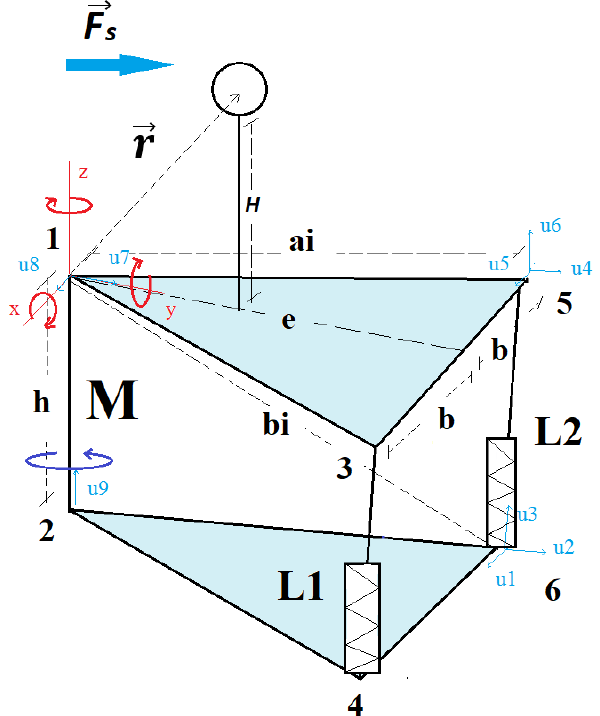
Figure 2. Simplified diagram of the parallel mechanism, where the plane triangles are isosceles and the line of length ‘e’ is the median of the triangle. The sphere is also represented, and within it is the → IMU. 𝐹 𝑠 ⃗⃗⃗ is the force resulting from the fluid dynamic forces, and 𝑟 is the vector of the center of the coordinates to the IMU.